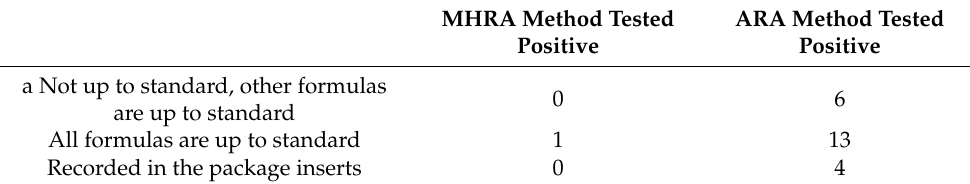
Table 6. Levonorgestrel ethinyl estradiol test results.